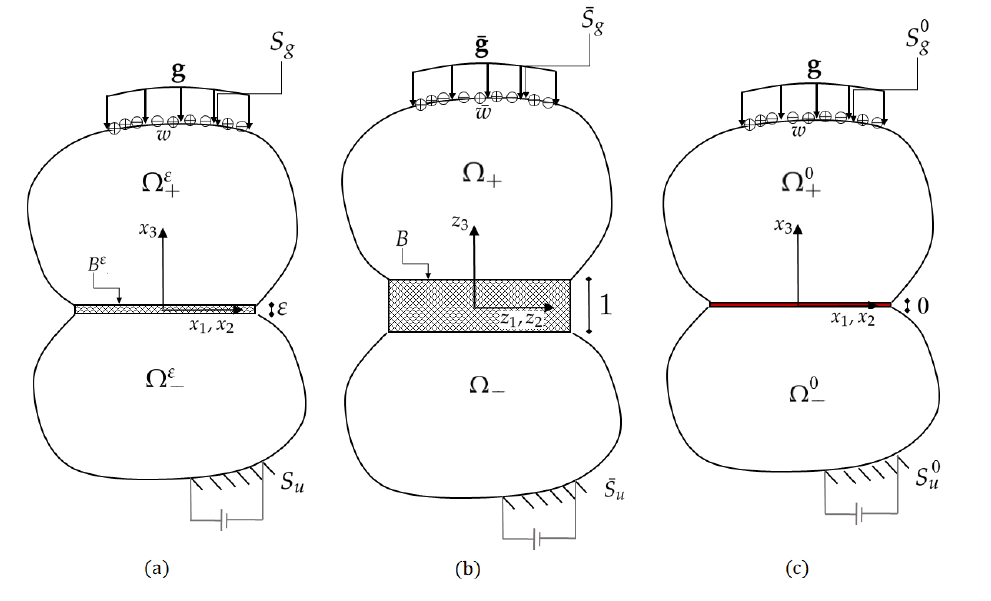
Figure 1. Geometry of the bonded assembly composed of two adherent bodies and an adhesive thin layer: reference configuration ( a ), rescaled configuration ( b ) and limit configuration ( c